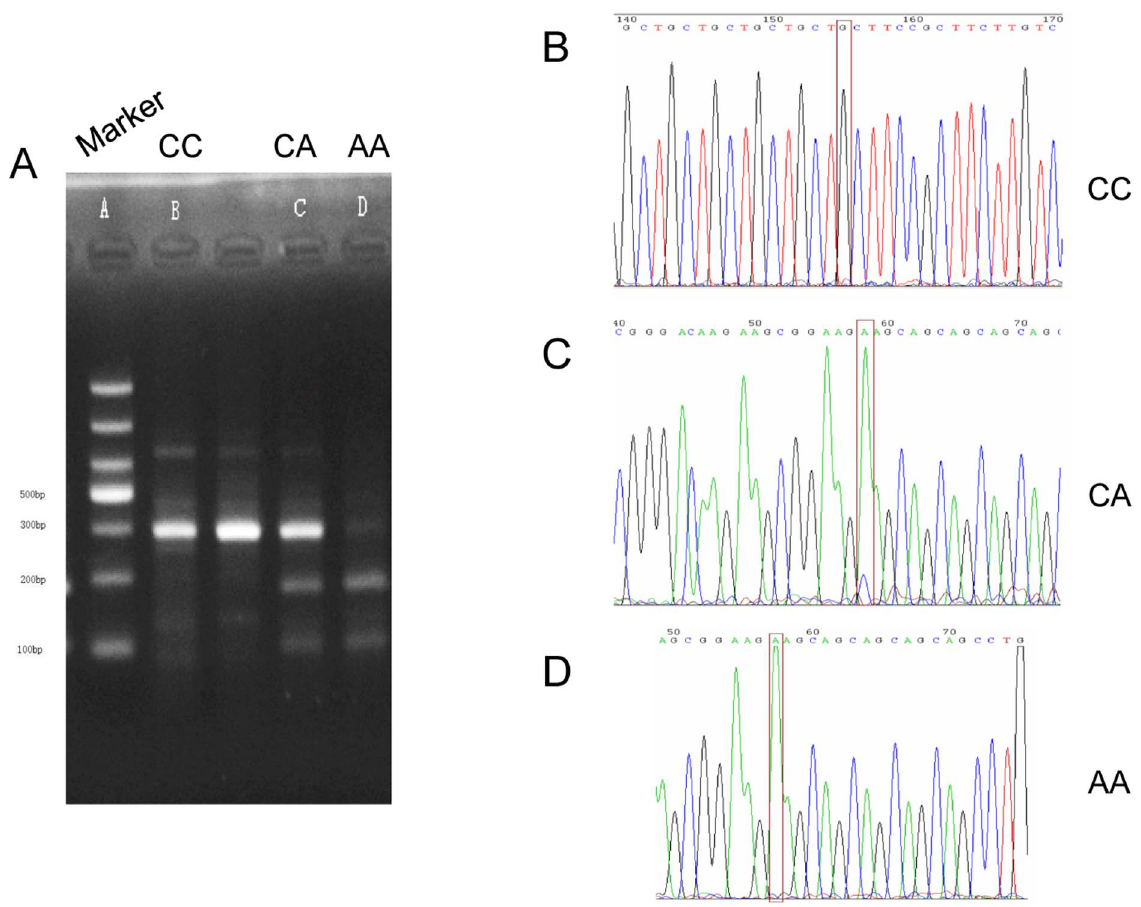
Figure 2. Genotype analysis for ERCC1 SNP C8092A. A) Post-digestion PCR of alleles CC, CA, and AA (left to right). B) Sequence analysis of CC genotype. C) Sequence analysis of CA heterozygous genotype. D) Sequence analysis for the AA genotype.